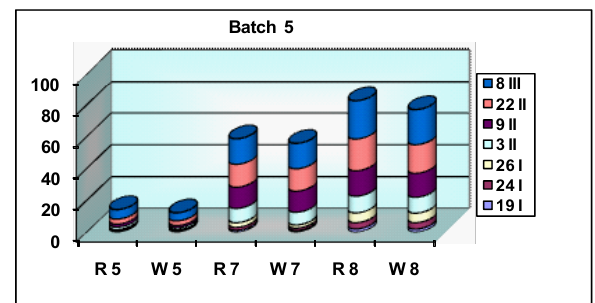
Fig. 9. The final average length of the branches, in cm, for batch